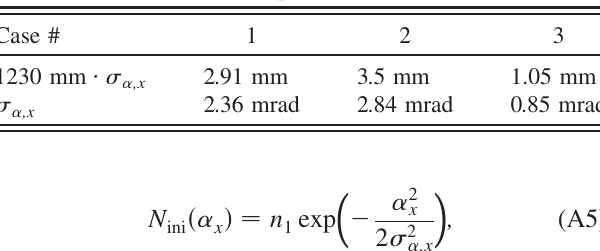
FIG. 18. F z ð z Þ —force acting on the test bunch (traveling be- hind the drive bunch at locations marked as case 1, or 2 or 3) is shown here computed for 9 nC of the drive charge (case #1), 10.6 nC of the drive charge (case #2), and 14 nC (case #3). The drive bunch is off the center of its respective channel by 3 mm toward the test channel. Accordingly, for each case the test bunch position and distribution is different, as indicated.